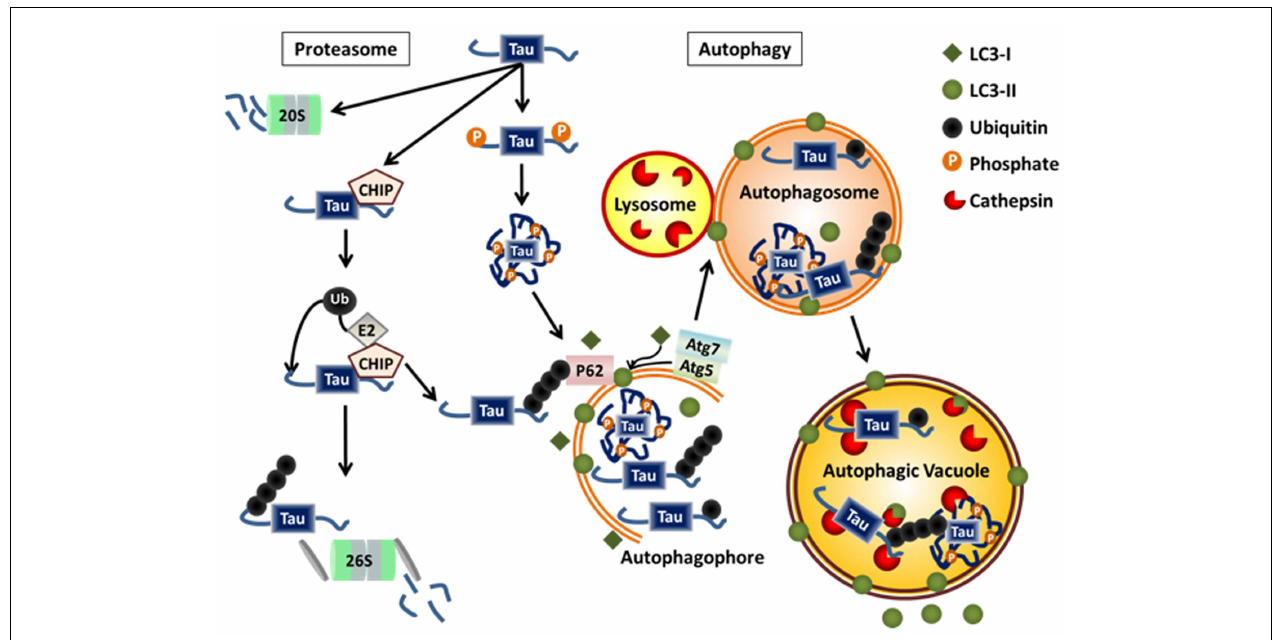
likely target for the 20S proteasome. Monomeric tau also interacts with the E3 ligase, CHIP, which can lead to its ubiquitylation and degradation via the 26S proteasome or autophagy. Certain cleavage products and phosphorylated forms of tau, as well as, monoubiquitylated tau and tau aggregates are selectively degraded by